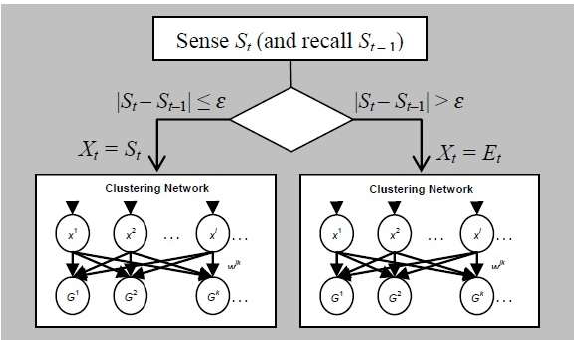
Figure 6: A two-network goal generation module for generating maintenance and achievement goals.